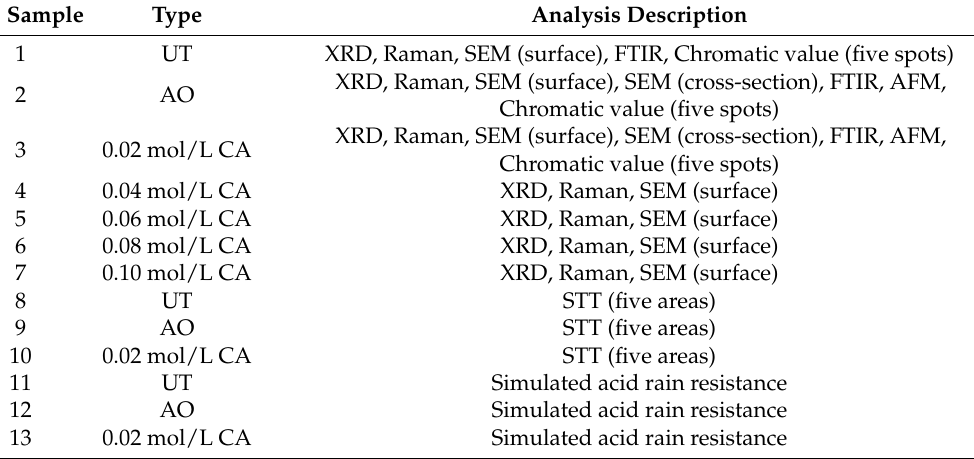
Table 1. Characteristics of the samples.